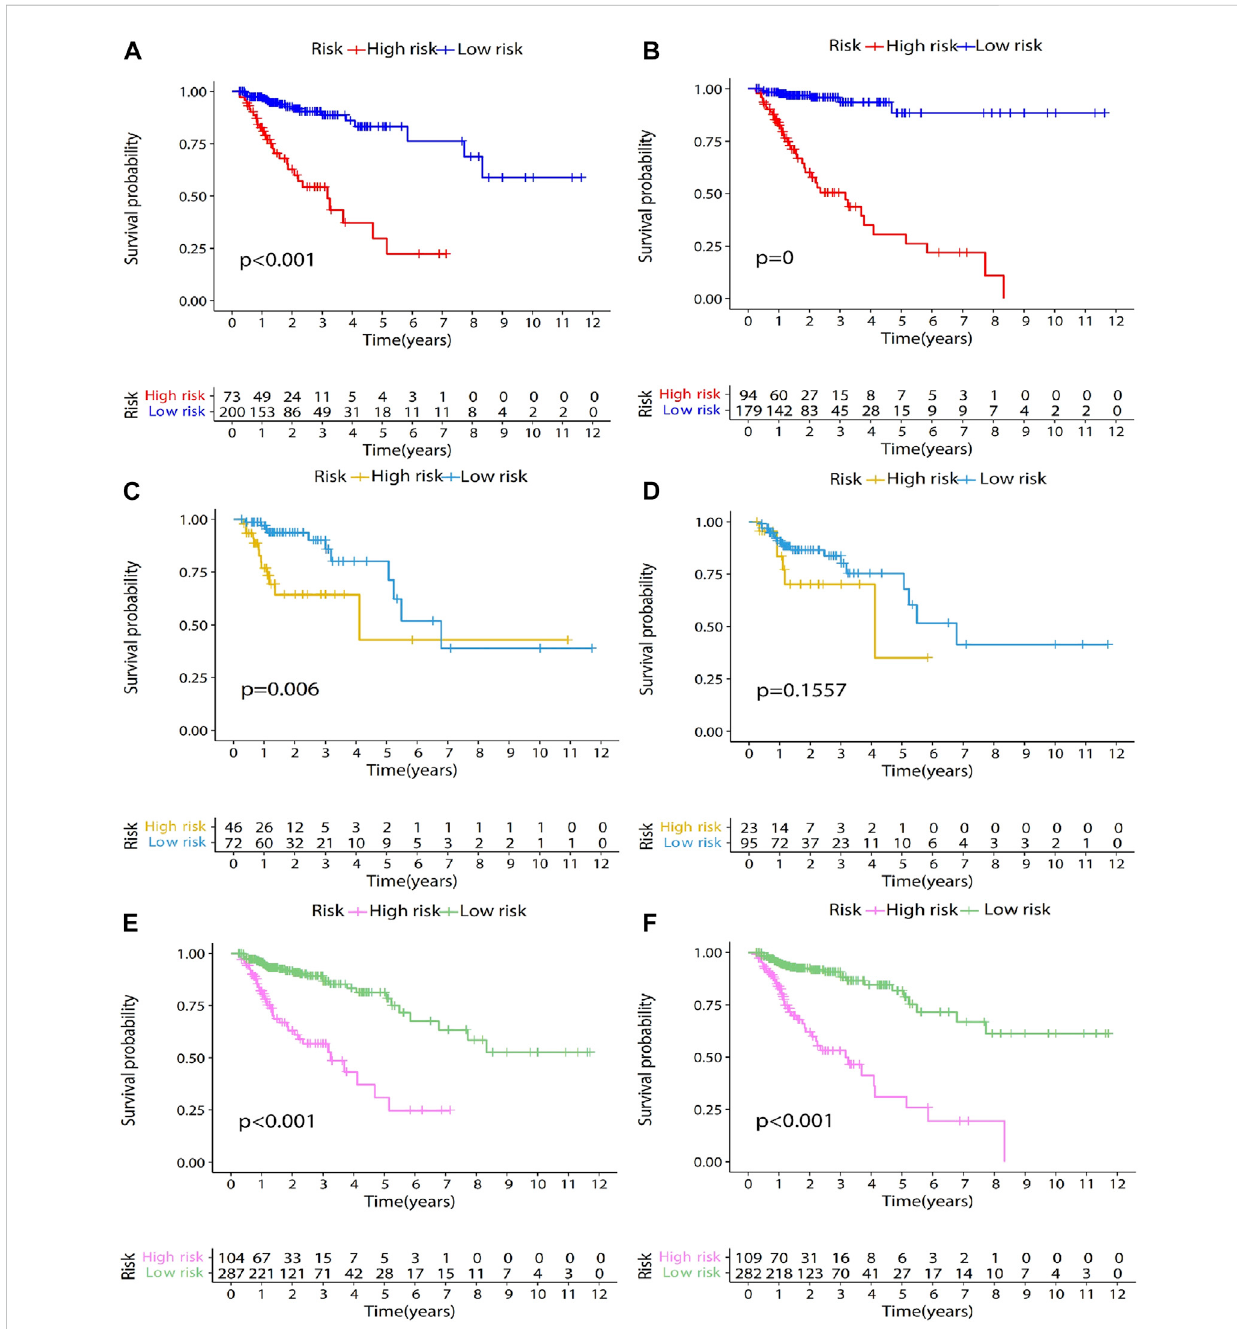
FIGURE 3 Survival analysis results of training dataset, testing dataset, and entire TCGA dataset. The genes were screened by LASSO regression, and the model was constructed by multifactor cox regression. The survival analysis results of the training dataset, the testing dataset, and the entire TCGA dataset are shown in Figures 3 (A,C,E) . After screening the genes through univariate Cox analysis, the survival analysis results of the training dataset, testing dataset and the entire TCGA dataset are shown in Figures 3 (B,D,F) . In the survival analysis chart, the x-coordinate represents the survival time, in years. The y-coordinate represents the survival probability. The patients were divided into two groups according to the optimal cut-off value. They are low-risk groupand high-riskgroup. p -value representsthedifference insurvival between thetwogroups.At thebottomofthe fi gure isatable.Theabscissaisthe survival time in years. The ordinate is the high-risk group and low-risk group, and the value represents the number of patients remaining at each time